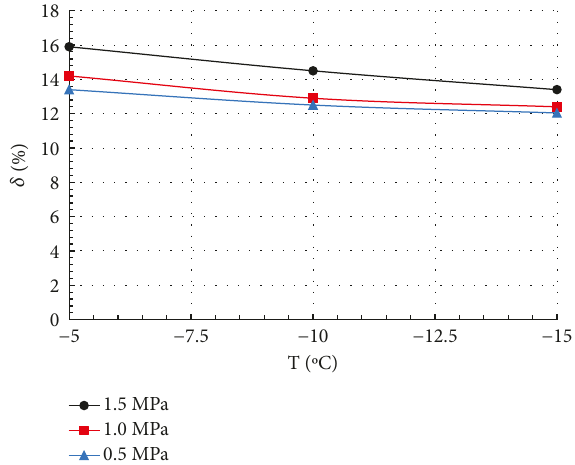
Figure 12: Relation between dynamic damping ratio and temperature.